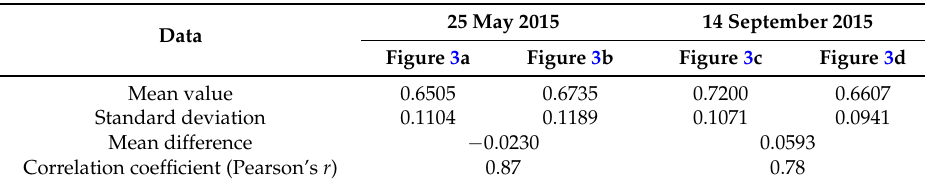
Figure 3. ( a – d ) Comparisons of the actual GF-1 NDVI images ( left ) and the corresponding fused images ( right ) on two dates. Table 4. Accuracy assessment for the STARFM simulation. The subdomains consist of 400 × 400 pixels were randomly selected. Figure 3a,c are the actual GF-1 NDVI images, Figure 3b,d are the corresponding fused NDVI images generated by the STARFM algorithm.